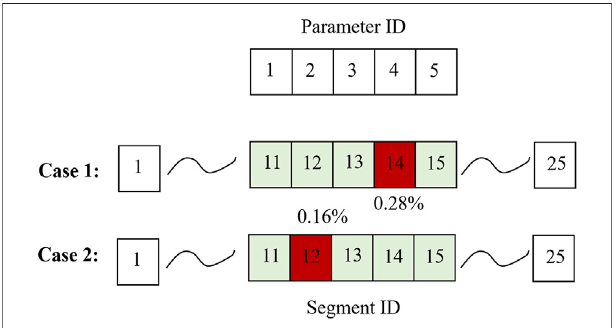
FIGURE 3 | Formulated cases with damage